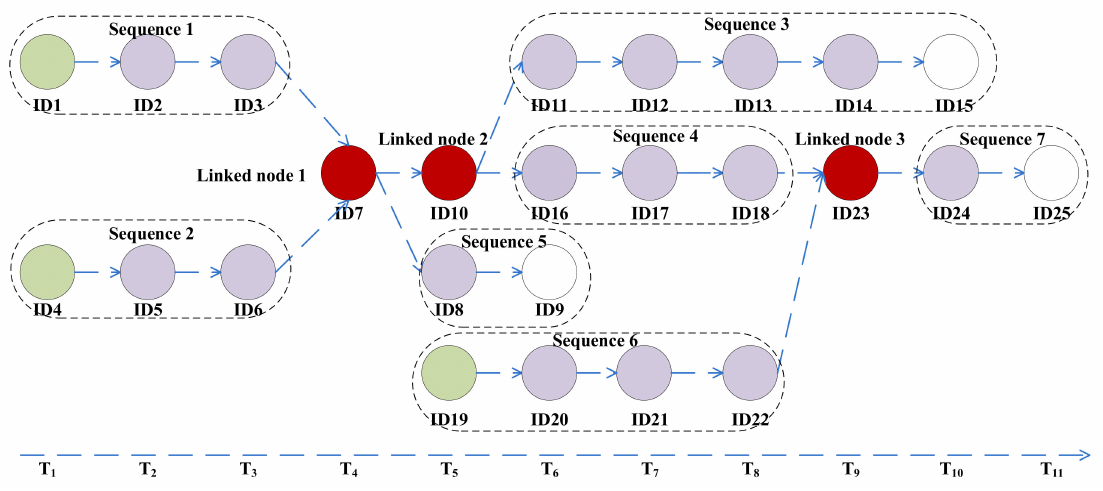
Figure 8. A simulated process.